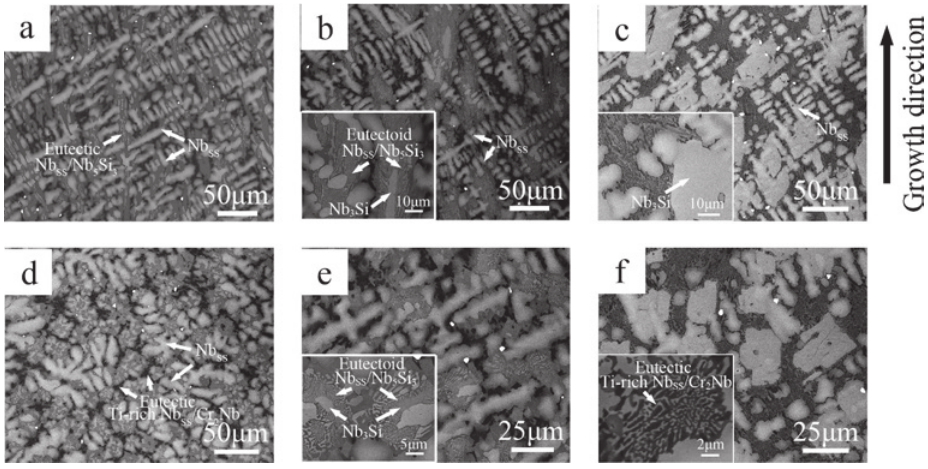
Fig. 2: Longitudinal (a, b, c) and transverse (d, e, f) microstructure of quasi-steady-state growth region. (a, d) region (IIIA); (b, e) region (IIIB); (c, f) region